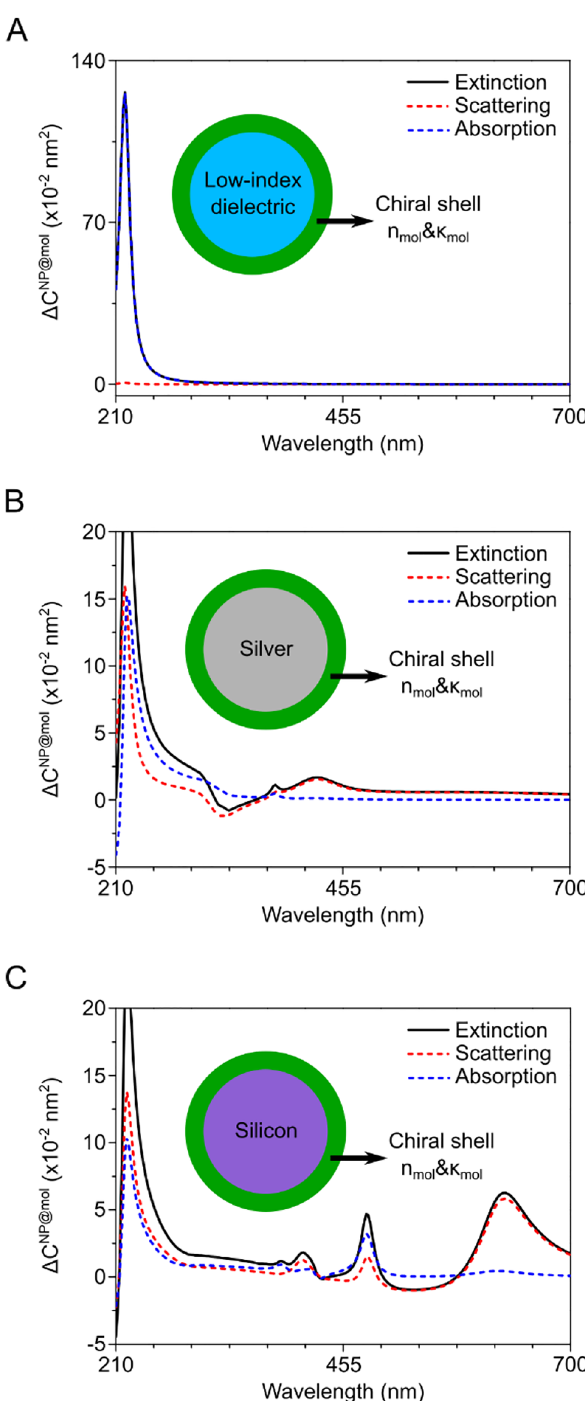
Figure 5: The circular differential extinction (black solid), scattering (red dashed) and absorption (blue dashed) cross section of (A) low- index dielectric core (B) silver core and (C) silicon core particle of radius 75 nm. The refractive index of the low-index dielectric mate- rial is the same as the achiral background